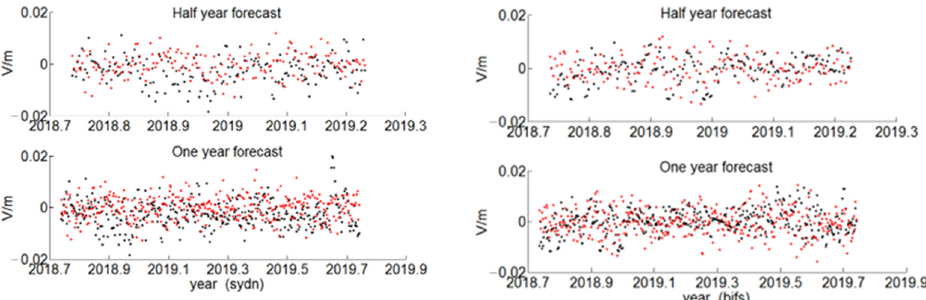
Figure 12. The GARCH residual sequence prediction of tlse and barh station.